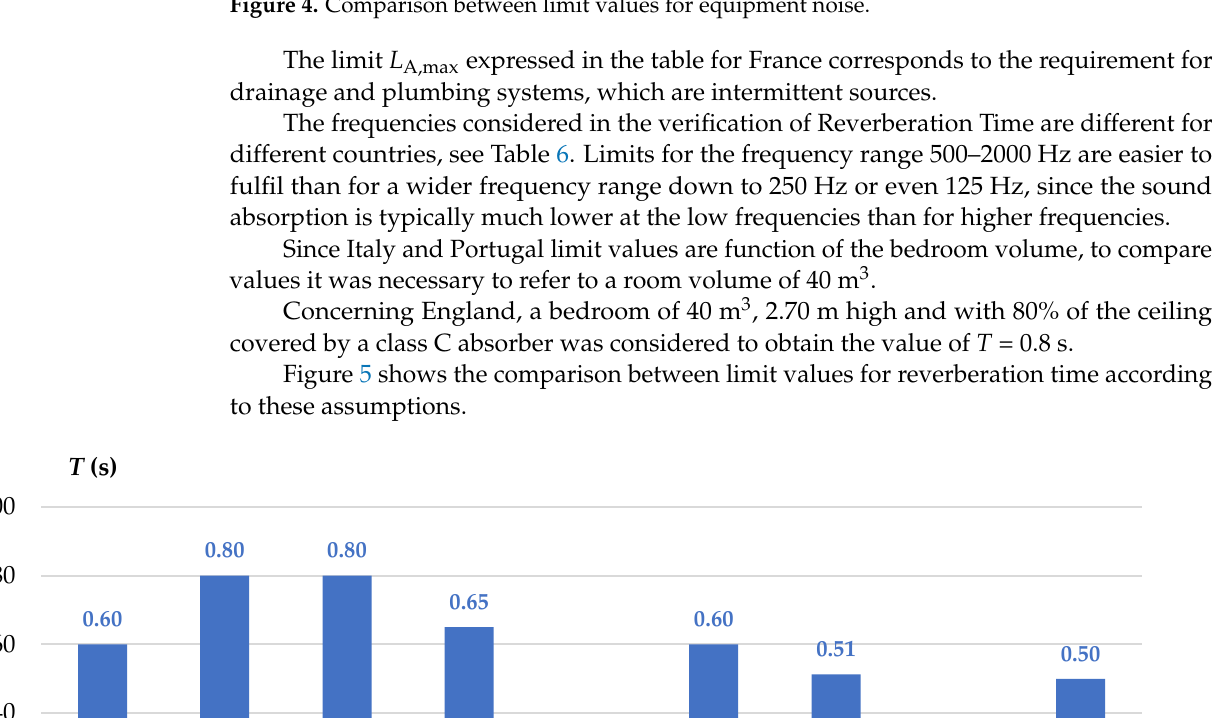
Figure 4. Comparison between limit values for equipment noise.